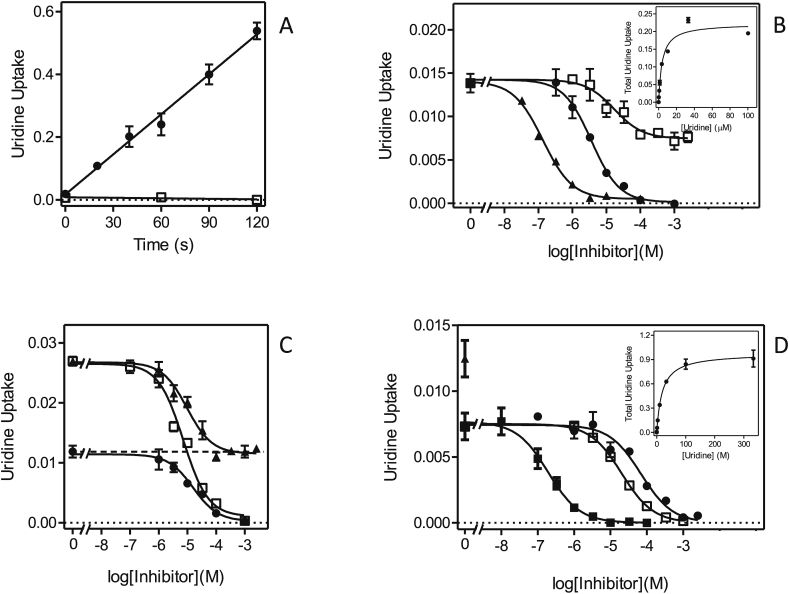
Transport of [3H]-uridine by L. mexicana promastigotes. (A) Transport of 0.25 μM [3H]-uridine was linear (r2 = 0.992) over 120 s with a rate of 0.0043 ± 0.0002 pmol(107 cells)−1s−1 (●). In the presence of 5 mM uridine (□) transport was not significantly different from zero (P = 0.43). (B) Transport of 0.25 μM [3H]-uridine was dose-dependently inhibited by unlabeled uridine (●), resulting in an apparently mono-phasic sigmoid curve that could be converted to a Michaelis-Menten saturation plot (inset) to determine Km and Vmax values. Transport was inhibited by 48% by up to 2.5 mM uracil (□), and ∼100% by adenosine (▲). (C) Transport of 0.25 μM [3H]-uridine was determined in the presence (●) or absence (□,▲) of 1 mM unlabeled uracil in order to inhibit the uracil-sensitive component of uridine uptake. Inhibitors shown are uracil (▲) and thymidine (□,●). The dotted line indicates the level of uridine uptake in the presence of 1 mM uracil with zero thymidine added. (D) Transport of 0.25 μM [3H]-uridine in the presence of 1 mM uracil was dose-dependently inhibited by adenosine (■), uridine (□) and cytidine (●). The uridine inhibition data was converted to a Michaelis-Menten saturation plot (inset). The level of [3H]-uridine in the absence of uracil or other inhibitor is also indicated (▲). Unit for transport was pmol(107 cells)−1 for frame A and pmol(107 cells)−1s−1 in frames B-D; symbols represent the average of triplicate determinations in a single representative experiment, and error bars represent SEM.